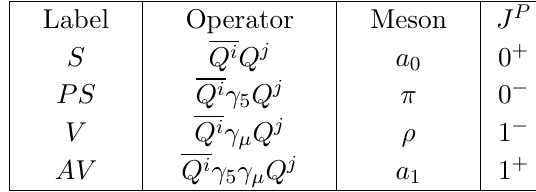
Table 2 . Interpolating operators, and corresponding (cid:13)avored particles (i.e. i 6 = j in the interpo- lating operators), studied in the body of the paper. Color and spinor indexes (summed over) are